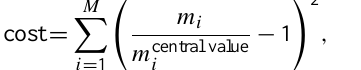
µGA as a function of number of possibilities and number of gen-